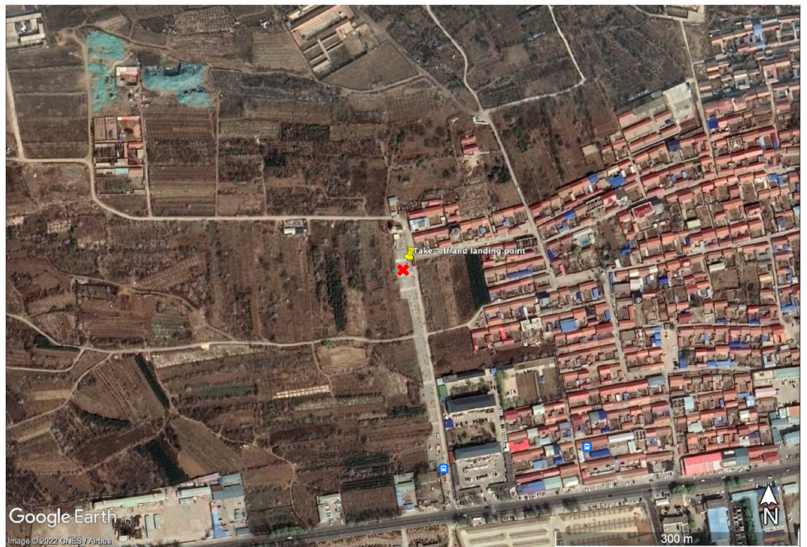
Figure 8. Google Earth satellite image of the test location (bounding box coordinates: 40.48367, 115.84961; 40.48415, 115.86112; 40.47819, 115.86104; 40.47827, 115.84982) and take-off point (40.48141, 115.85544) for all flights. The red cross represents the position where ground level CO 2 sensor was placed. While the yellow pin represents location of take-off and landing, which is approximately 10 m apart from the ground level sensor.